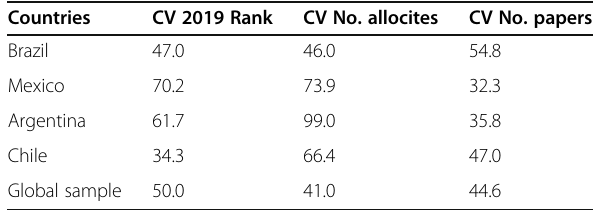
Table 6 Coefficients of variation, CV (%), regarding position in the Single-year impact ranking-2019, No. allocites, and